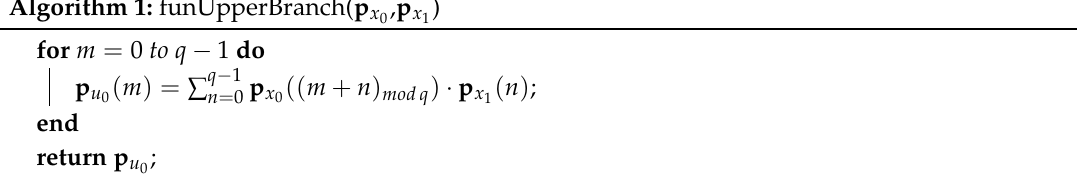
Algorithm 1: funUpperBranch( p x